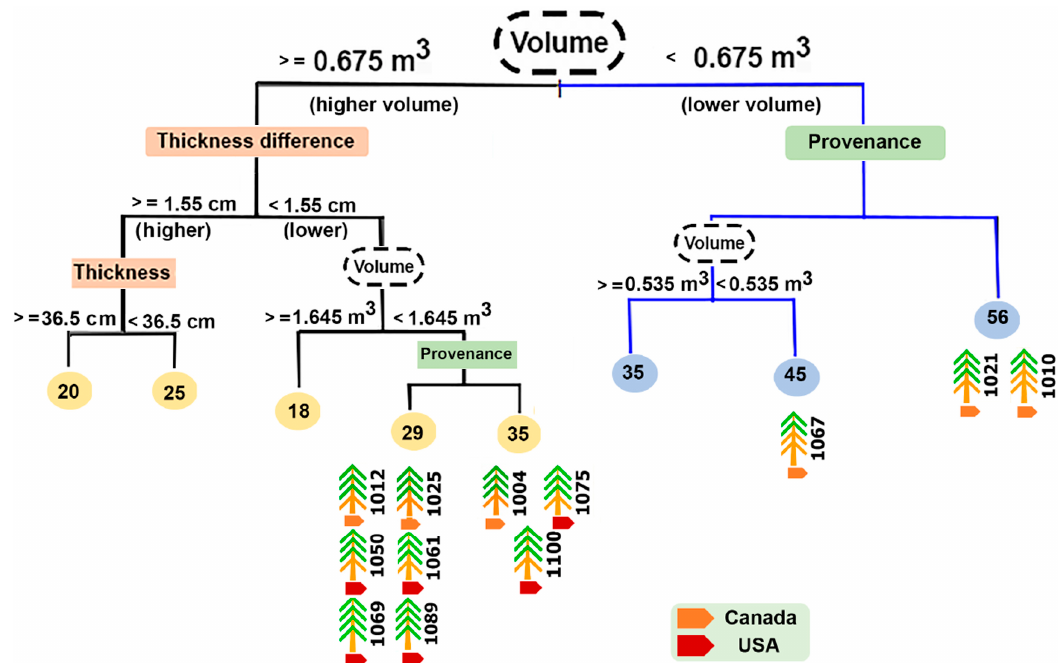
Figure 4. The decision tree based on the factors that influence the Central European Douglas fir stands health status. At the end of the nodes, the mean defoliation is mentioned. A higher number represents a more damaged tree. Healthier trees are on the left (black part of the decision tree) whereas more damaged trees are on the right side (blue part of the decision tree). Factor importance for splitting the arms decreases with the floor. Values dividing the nodes are stated for each arm. Selected typical provenances are stated with marking of country origin (Canada/ USA).